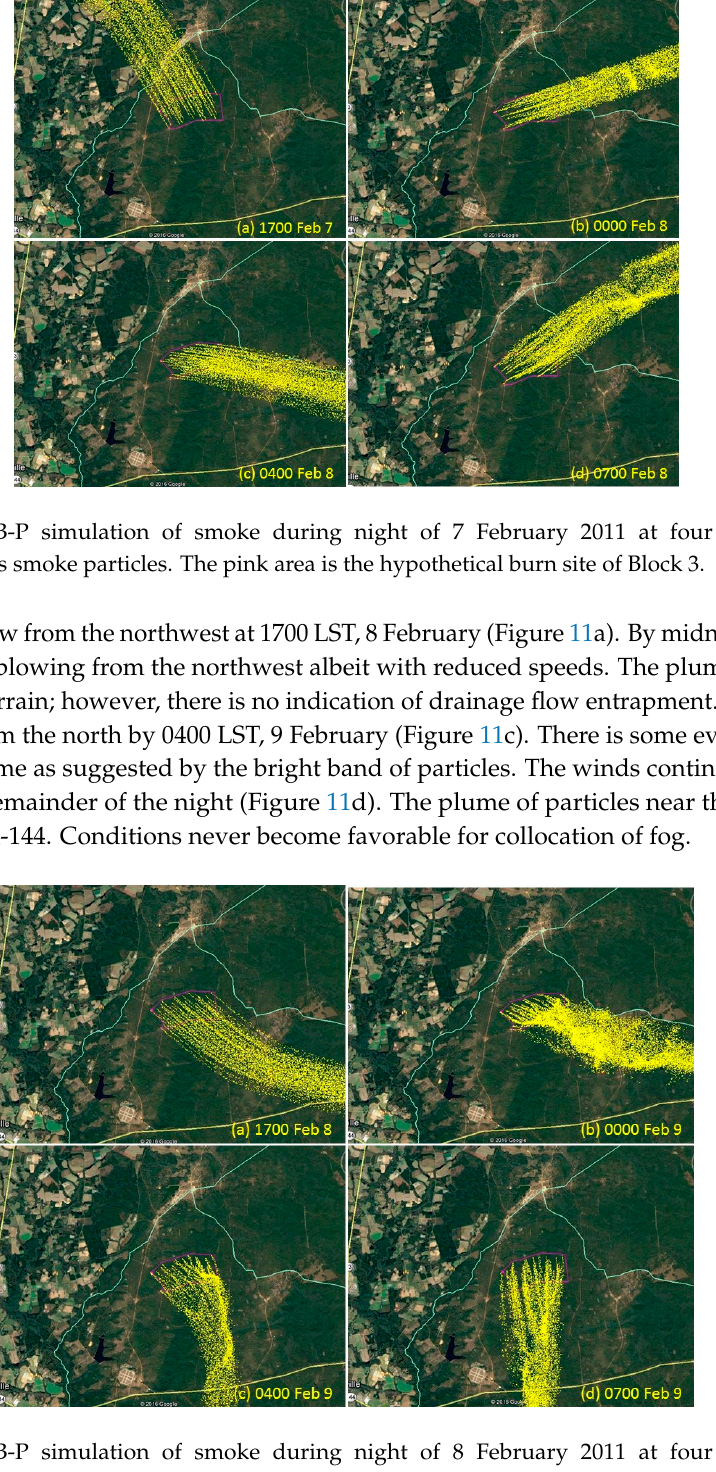
Figure 11. PB-P simulation of smoke during night of 8 February 2011 at four times ( a – d ). Yellow indicates smoke particles. The pink area is the hypothetical burn site of Block